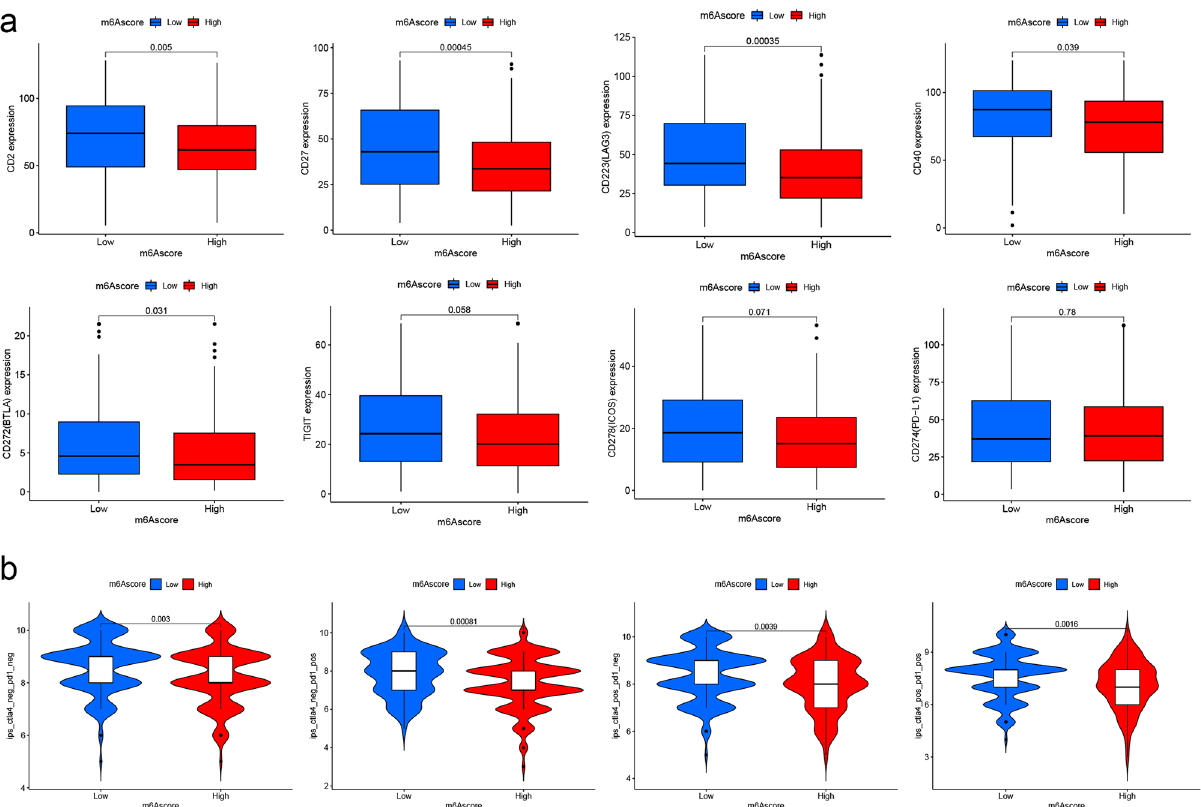
Figure 6. Immune checkpoint expression analysis and immunotherapy exploration based on M 6 AScore. ( a ) Expression differences in immune checkpoints (CD2, CD27, LAG3, BTLA, TIGIT, ICOS) between different m 6 AScore groups. ( b ) The comparison of the relative distribution of immunophenoscore (IPS) between different m 6 AScore